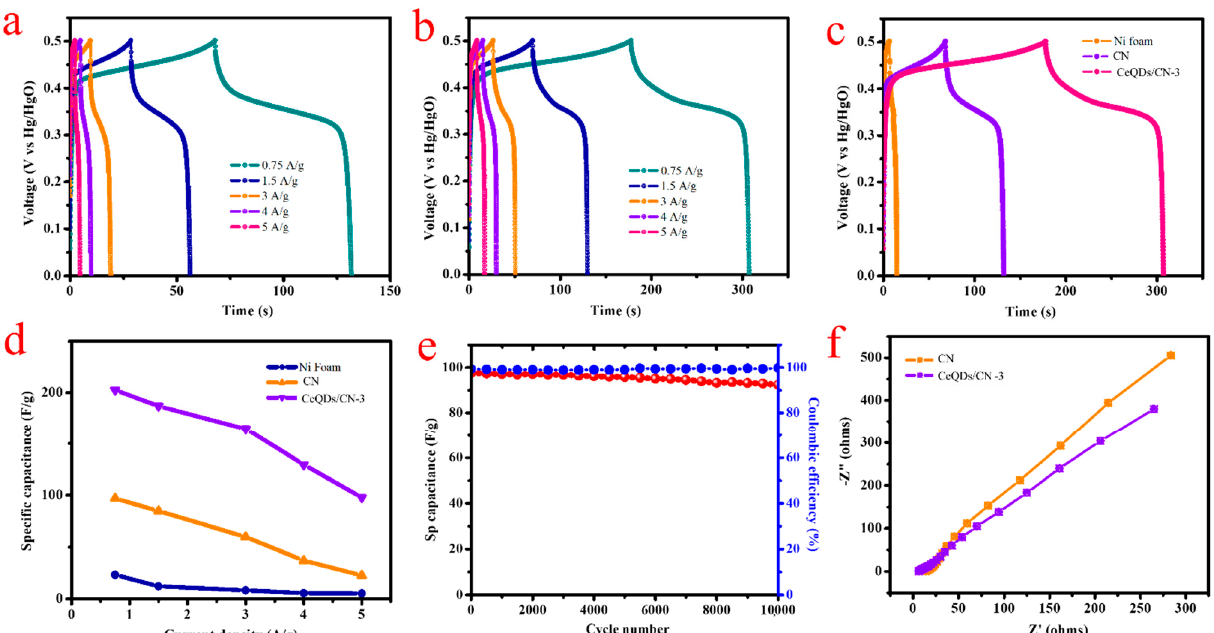
Figure 6. Charge/discharge curves of ( a ) CN and ( b ) CN/CeQDs-3, ( c ) comparison of charge discharge curves of bare nickel foam, CN and CN/CeQDs-3, ( d ) specific capacitance vs. current density of bare nickel foam, CN and CN/CeQDs-3, ( e ) cycling stability CN/CeQDs-3, and ( f ) EIS spectra of CN and CN/CeQDs-3 nanostructure.